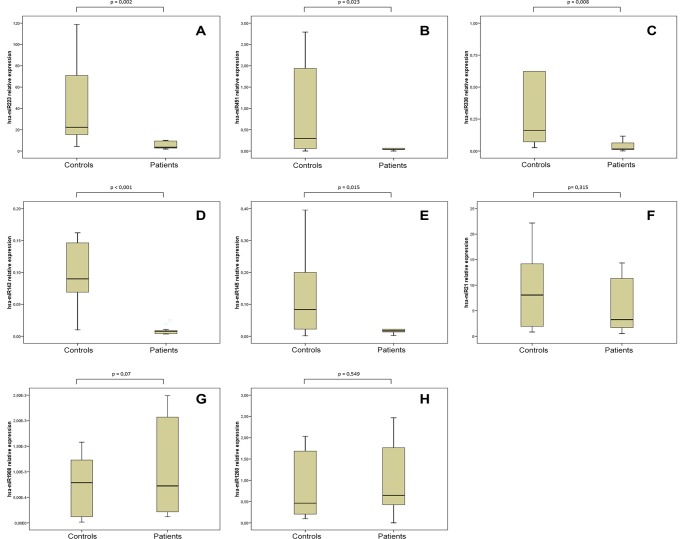
Boxplots showing qPCR validation of miRNome from FM patients and controls.Panels A-F show qPCR results for the miRNAs with striking downregulation (over 4-fold) in microarray analysis. Panels G and H show qPCR results for the miRNAs not downregulated in FM as per microarray analysis. P<0.05 was considered significant. Analysis was performed using the SPSS package 13.0 (SPSS Inc, Chicago, IL, USA).